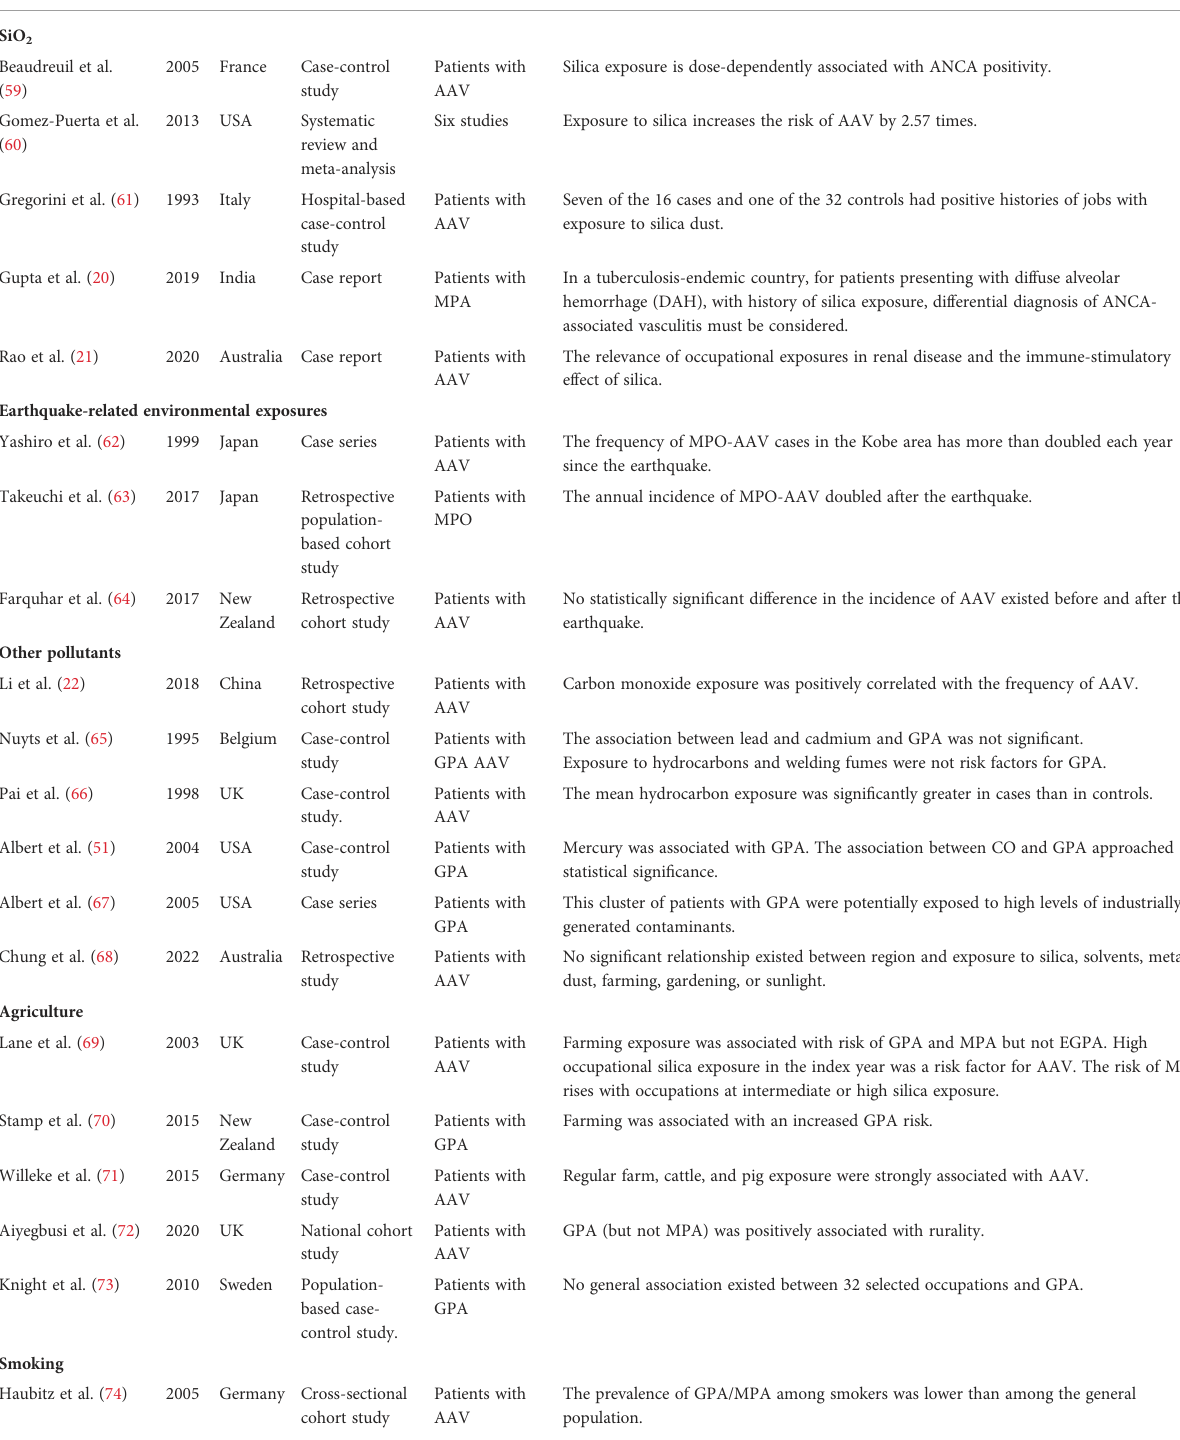
TABLE 1 Study on the relationship between environmental pollutants and